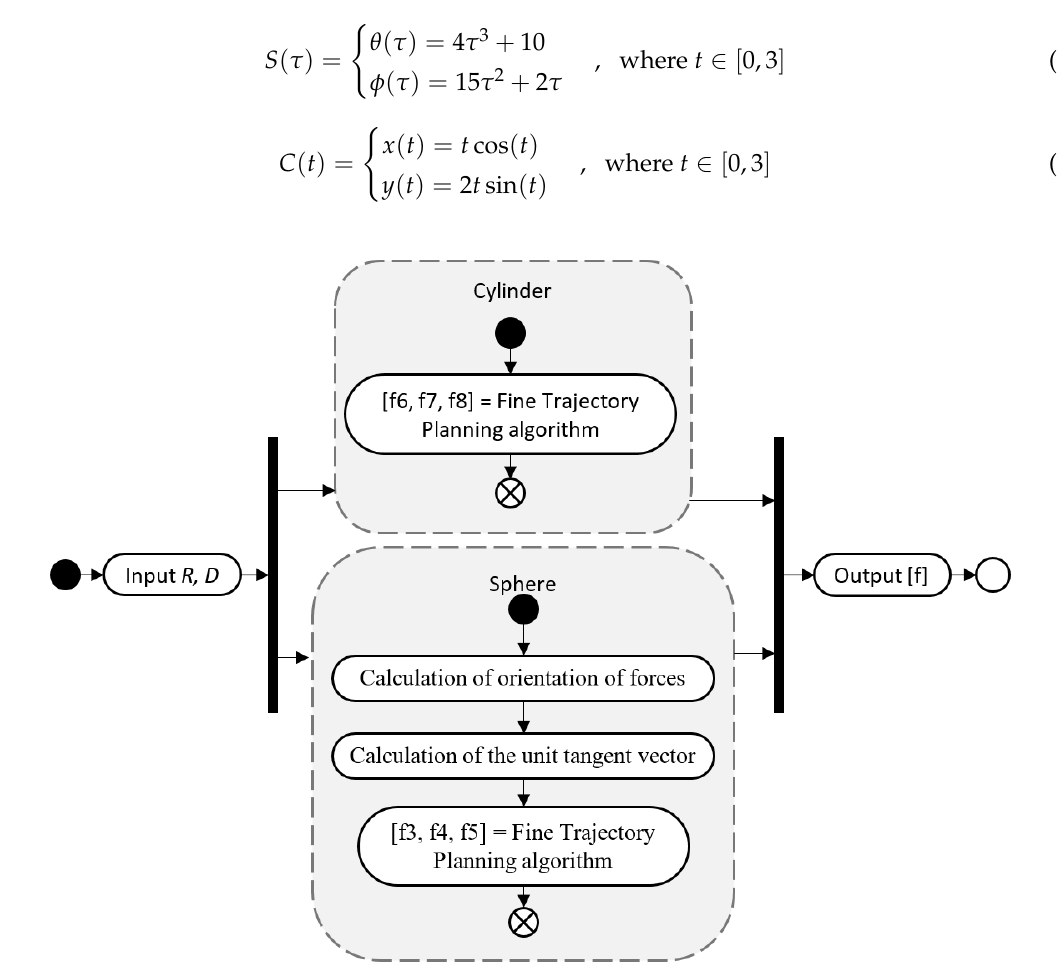
Figure 9. The integration system of the fine trajectory planning